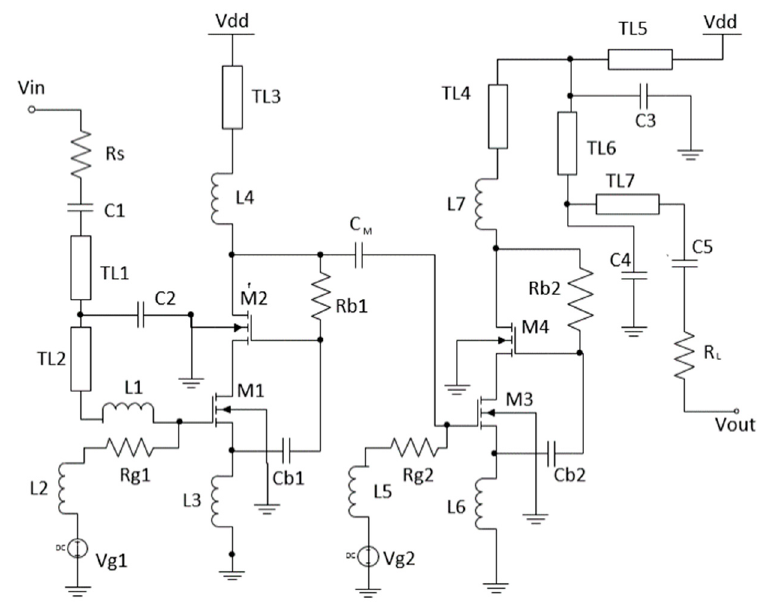
Figure 8. Two-stage self-biased cascode PA [17].